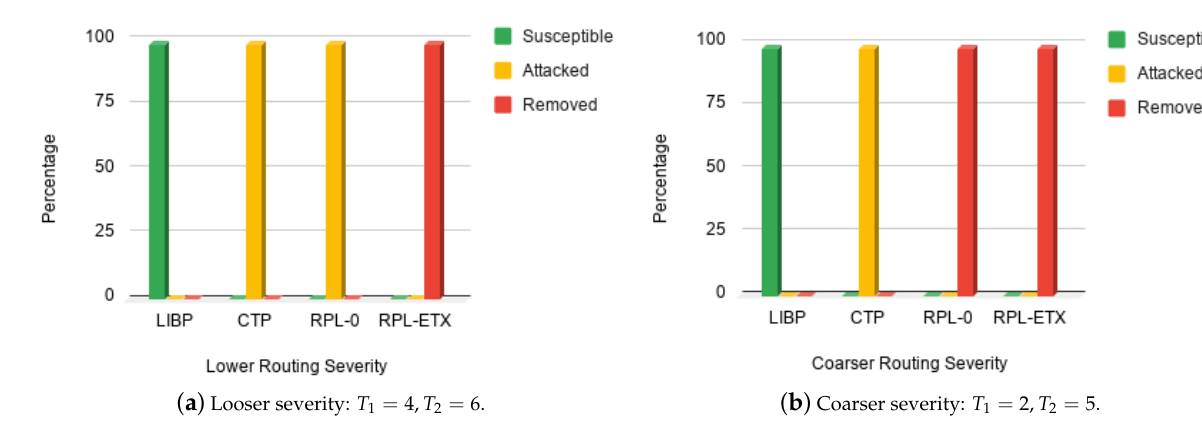
Figure 11. Epidemic profile: Interference and path